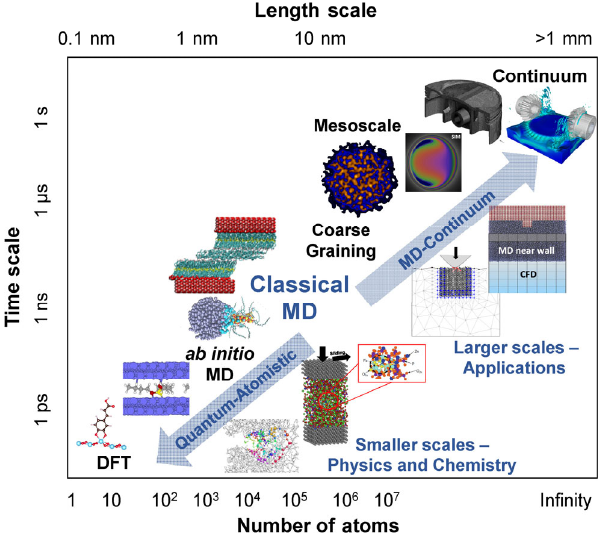
Fig. 7 Different scales for simulations of tribological systems. The map highlights areas of current interest for the development of coupling strategies to link MD simulations to quantum mechanical and continuum descriptions, with examples portrayed across the